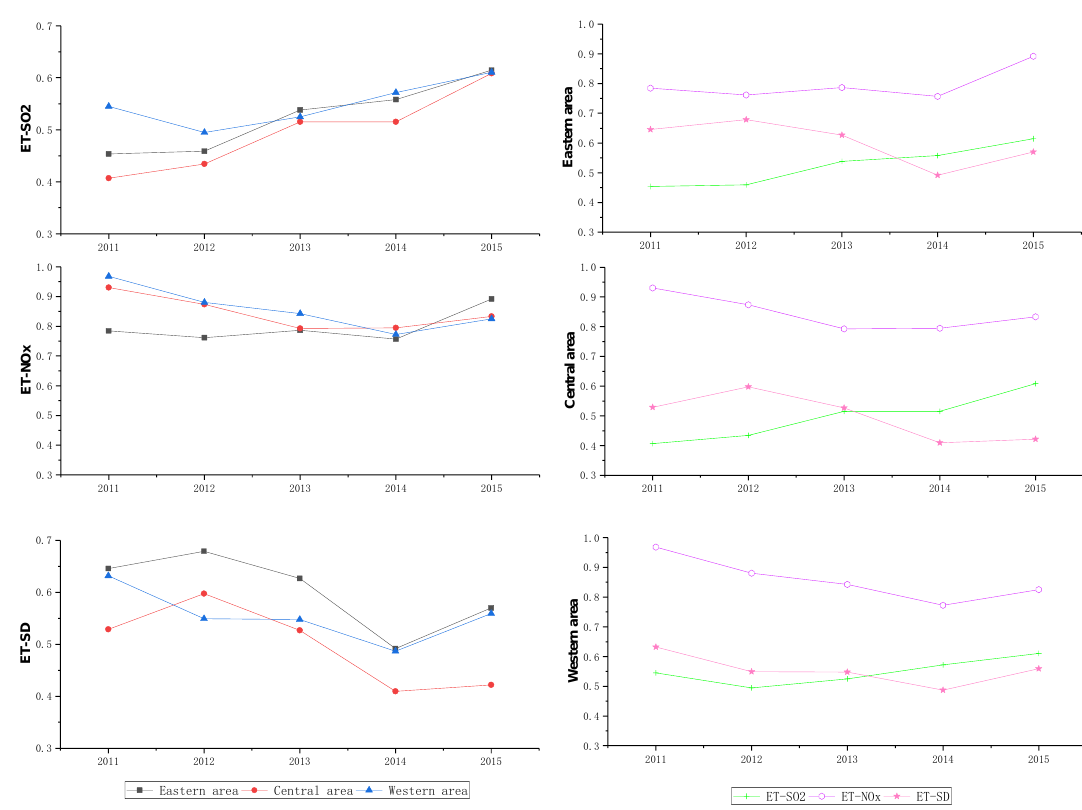
Figure 10. The ET efficiency of SO 2 , NOx, and SD. Figure 10. The ET e ffi ciency of SO